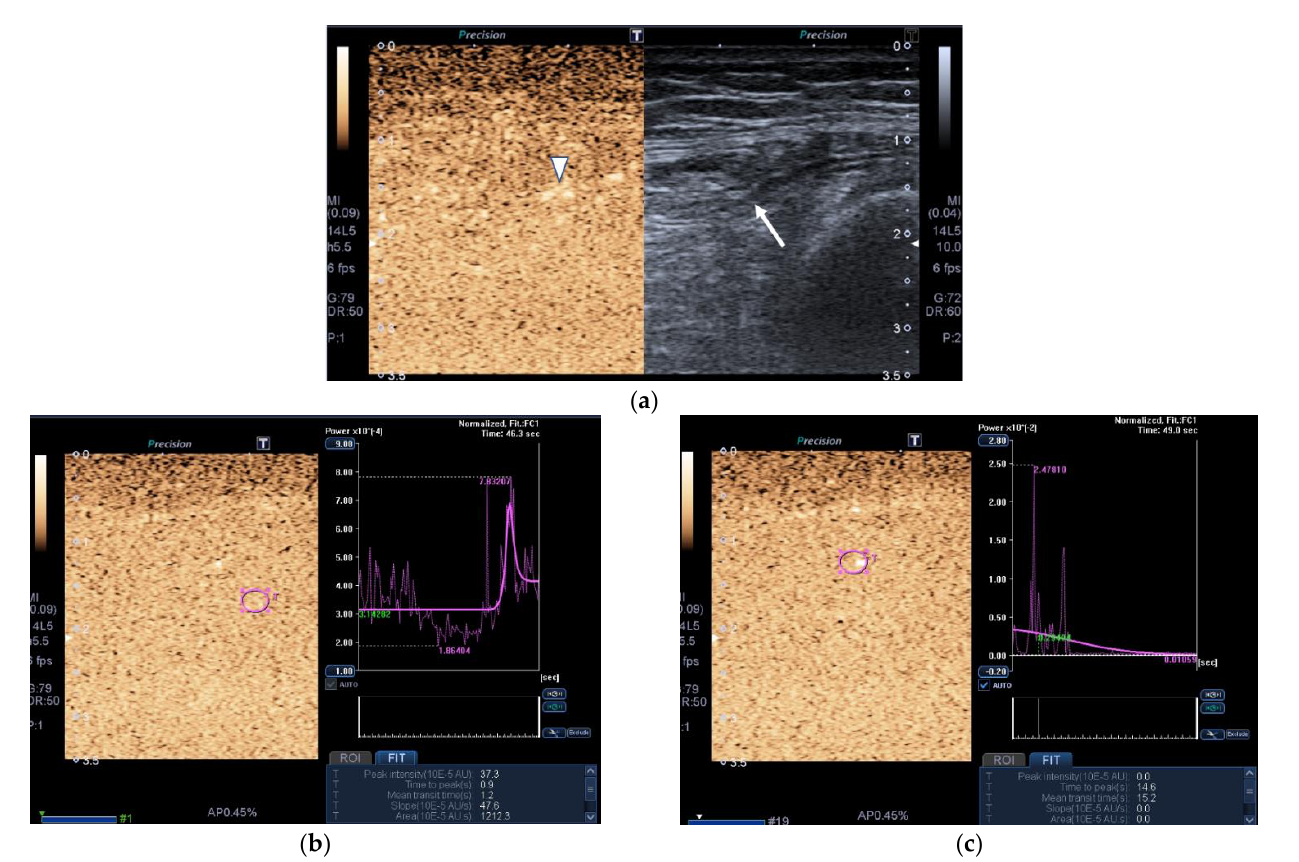
Figure 4. Transversal QRF muscle of a patient with multiorgan failure (77 years old). ( a ). Transversal ultrasonography scan shows the QRF muscle (arrow) and vascularization after contrast-enhanced ultrasound (CEUS) administration (arrowhead). CEUS imaging and time–intensity curve analysis are shown using the built-in software. ( b ) ROI (pink circle) in the area of strongest enhancement indicates maximum perfusion in the QRF. ( c ) ROI (pink circle) in the area of lowest enhancement indicates minimum perfusion in the QRF.